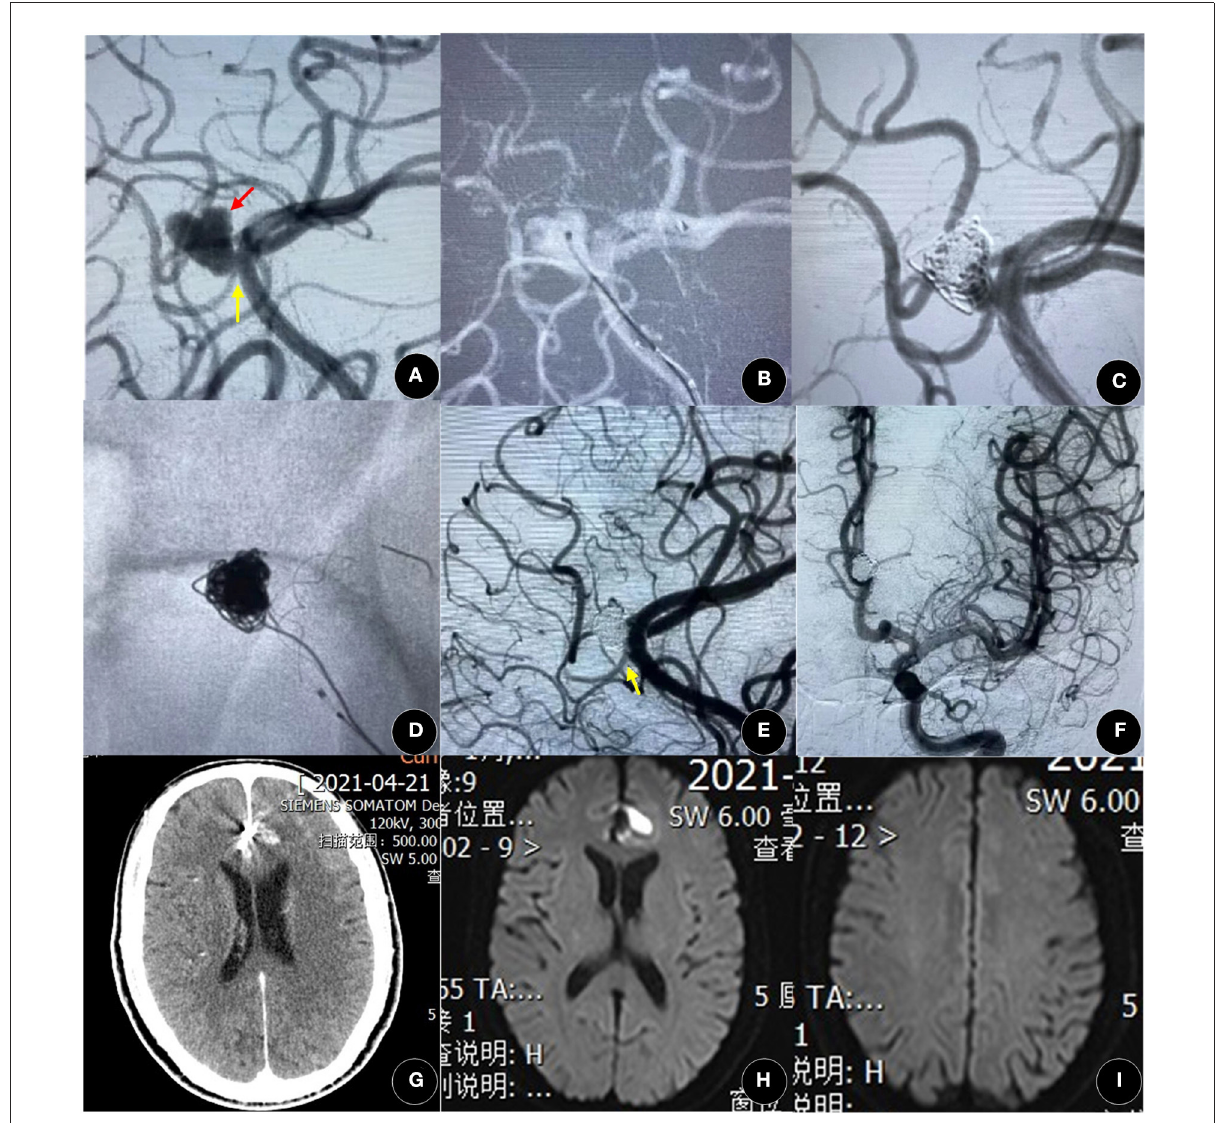
FIGURE2 A 60-year-old woman presented with spontaneous SAH for 3 days. (A) The angiographic result showed a left lobular A3 aneurysm (black arrow) with a side branch (yellow arrow). (B,C) After coiling, the aneurysm was in incomplete occlusion [Raymond-Ray Occlusion Class (RROC) 3c]. (D–F) The aneurysm was achieved in complete occlusion (RROC 1) after the deployment of the Leo plus baby stent (2.5mm × 18mm), and the side branch was not affected (yellow arrow). (G–I) There was no new cerebral hemorrhage or infarction by computed tomography (CT) and magnetic resonance imaging (MRI). A3, the third segment of the anterior cerebral artery; SAH, subarachnoid hemorrhage.